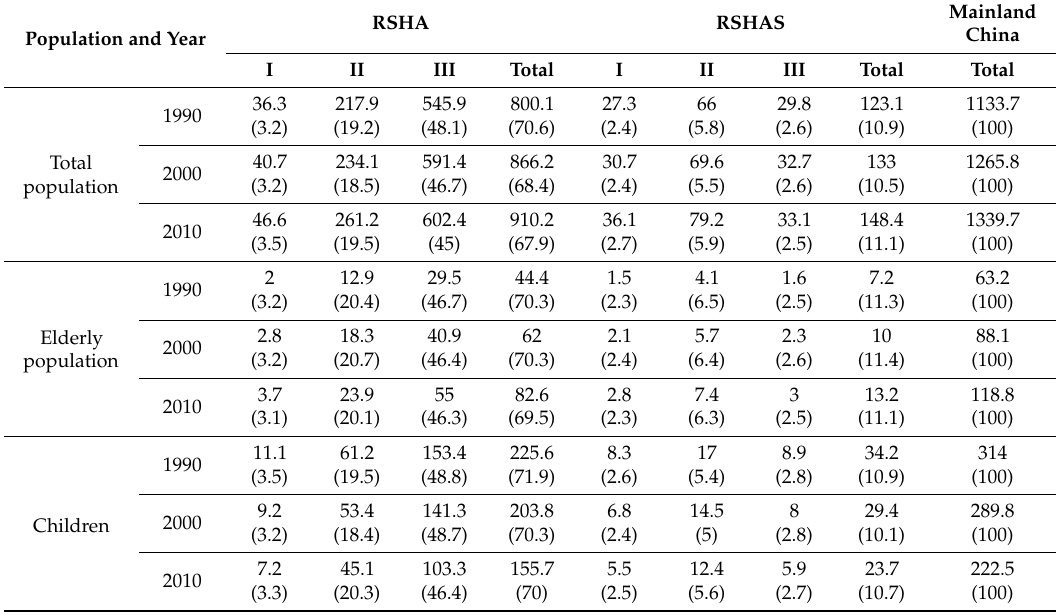
Table 1. Population exposure in the RSHA and RSHAS in 1990, 2000 and 2010, units: